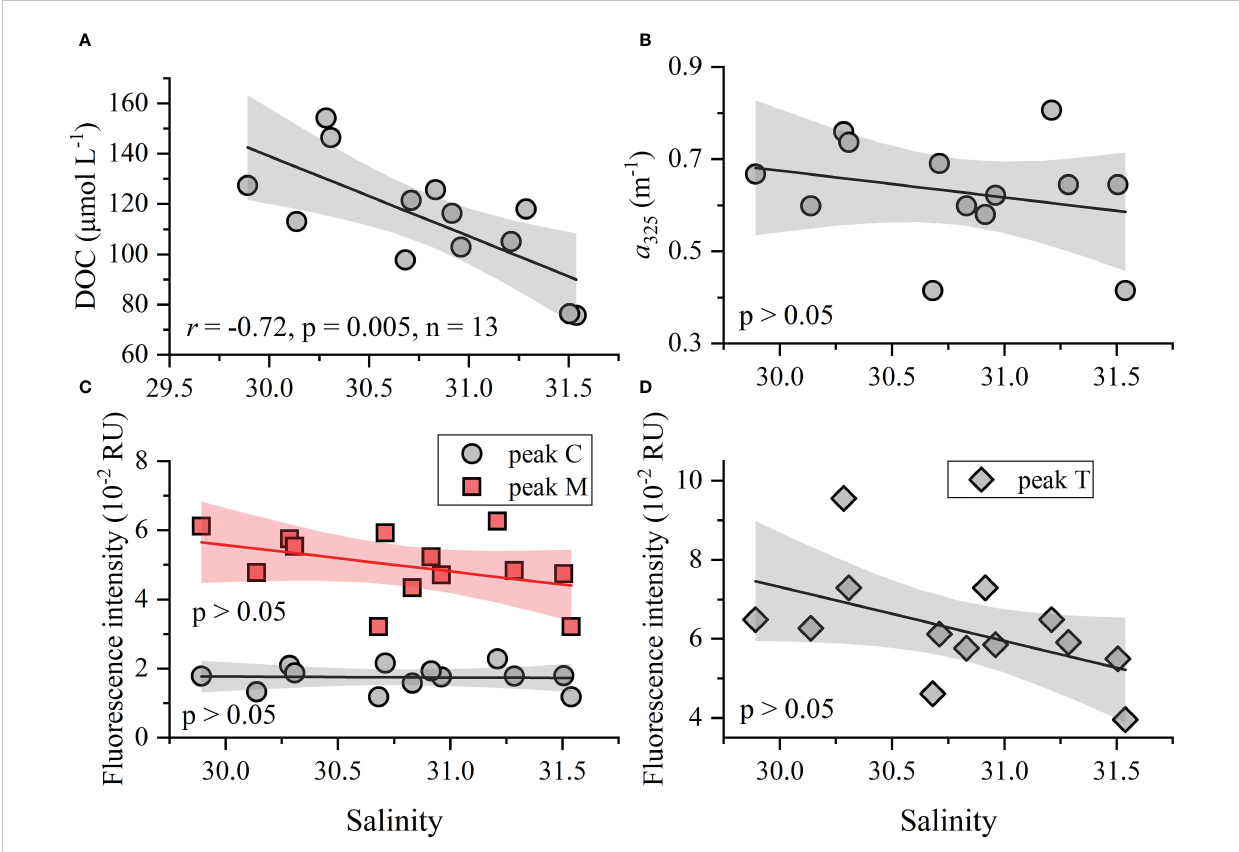
FIGURE 5 Relationships between DOC, CDOM, FDOM, and salinity. Shading represents the 95% con fi dence bands for the fi tting regression